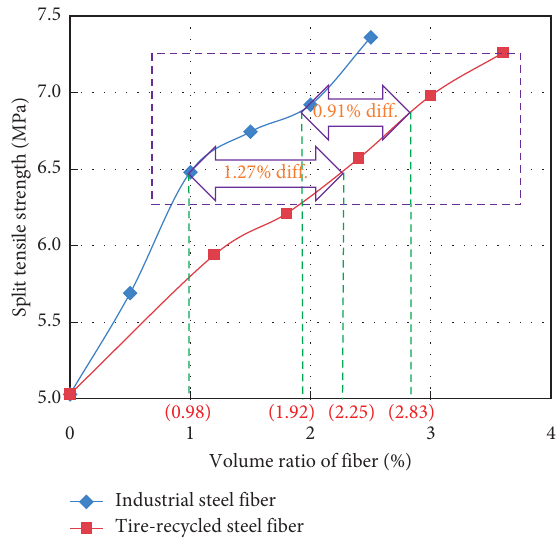
Figure 3: The split tensile strength of two types of steel fiber reinforced